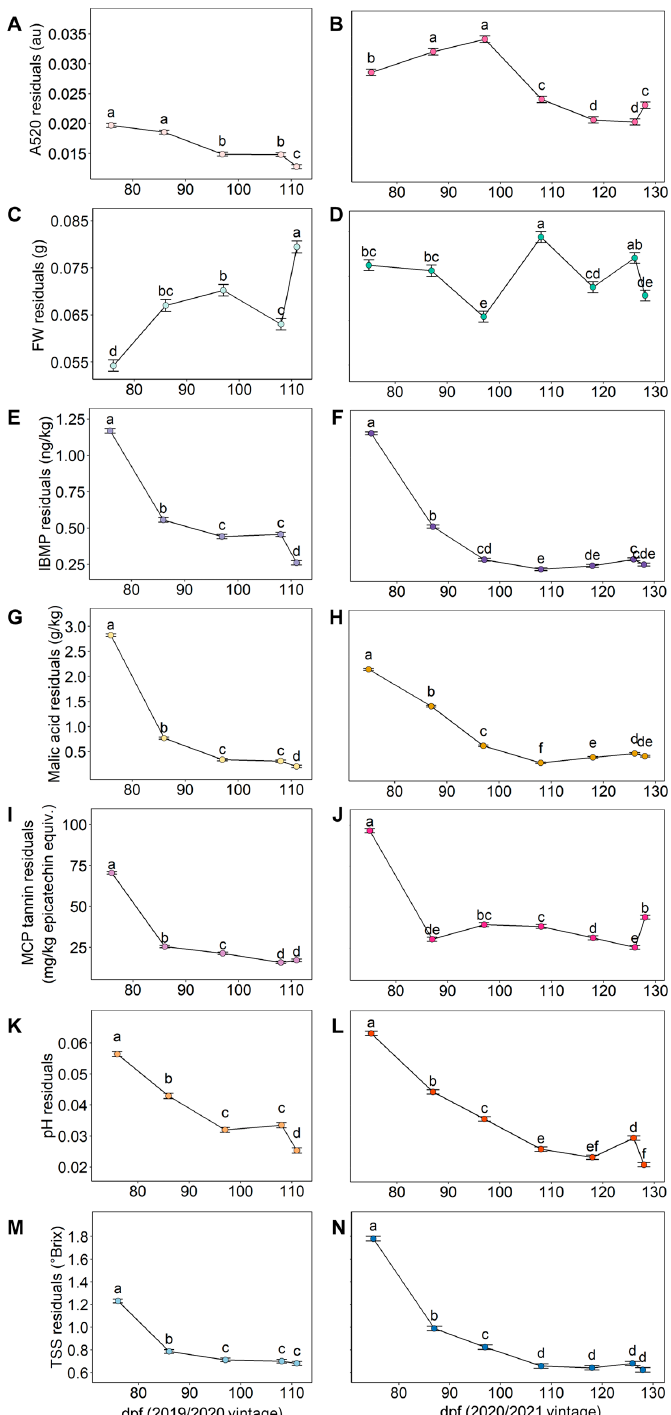
Figure 1. Changes in the bunch-to-bunch variability (absolute residuals) within a vine between sampling dates (days post-flowering, dpf) for ( A , B ) absorbance at 520 nm (A520), ( C , D ) berry fresh weight (FW), ( E , F ) 3-isobutyl-2-methoxypyrazine (IBMP), ( G , H ) malic acid, ( I , J ) methyl cellulose precipitable (MCP) tannin, ( K , L ) pH, and ( M , N ) total soluble solids (TSS) over the 2019/2020 ( A , C , E , etc.) and 2020/2021 ( B , D , F , etc.) seasons according to mean ± SEM ( n = 24 vines per sampling date). Different lower-case letters within a vintage for a given measurement represent significant differences between sampling date (linear mixed model, α = 0.05, Bonferroni-adjusted).